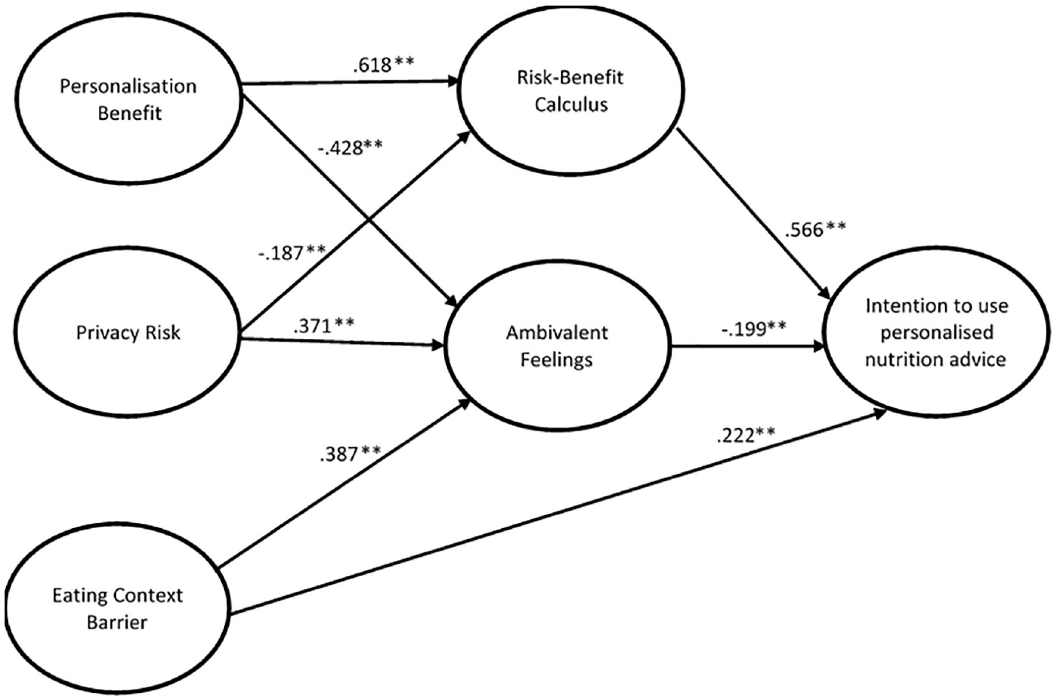
Fig 1. Final model–Significant paths. Note: Only the significant path coefficients of the latent variables are shown. All item loadings were significant. For reasons of clarity, we decided not to report the item loadings and standardized error variances. � p < .05; �� p <